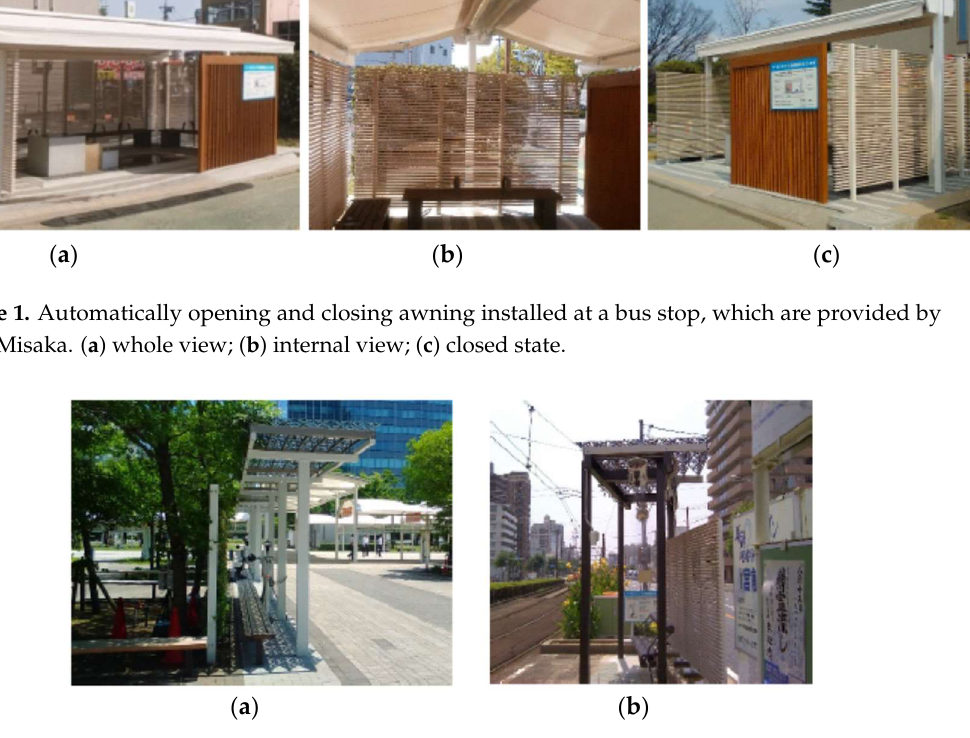
Figure 2. Fractal-shaped sunshade, which is provided by Prof. Misaka. ( a ) in a park; ( b ) at a tram stop.